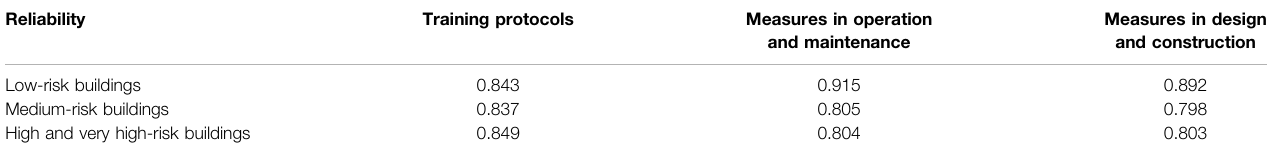
TABLE 1 | Reliability table by different sections of the questionnaire.